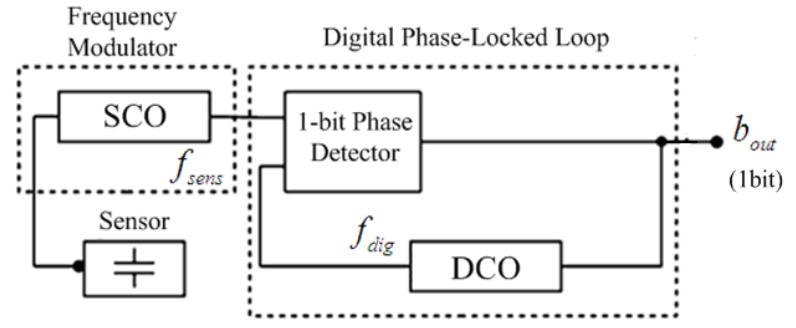
Figure 2. Architecture of PLL-based sensor interface.